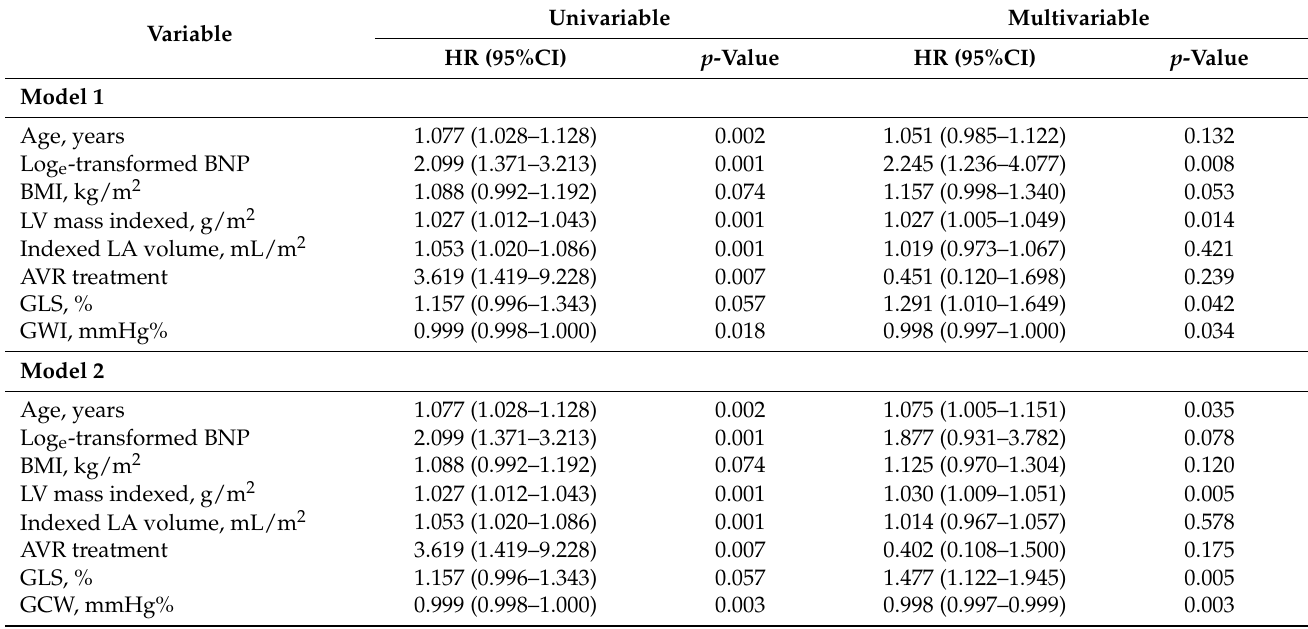
Table 5. Univariable and multivariable Cox proportional hazard model for cardiovascular mortality for asymptomatic aortic stenosis